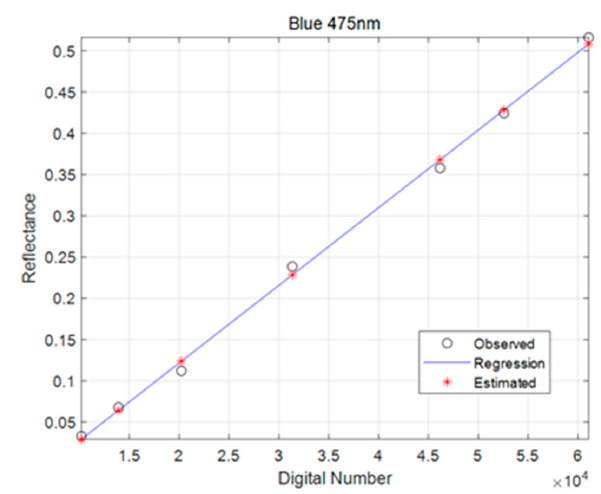
Figure 7. An examples of linear regression analysis between the digital number and the reflectance for blue band needed to estimate vicarious calibration coe ffi cients ( a a and b a ) of a reference